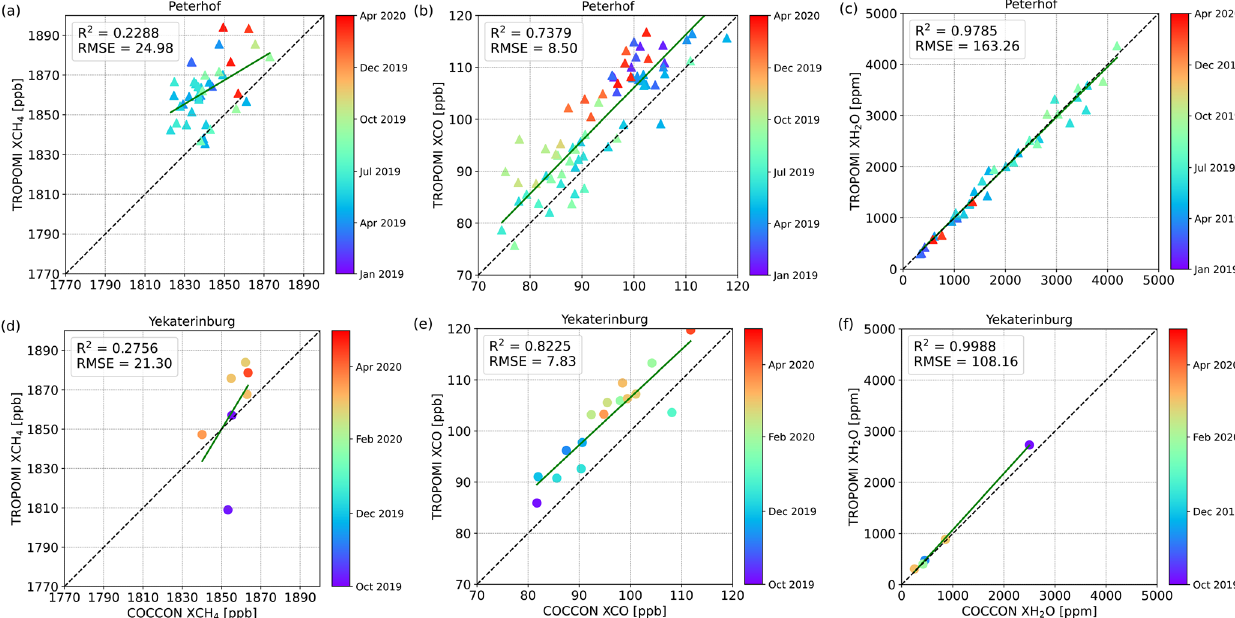
Figure 10. Correlation plots between TROPOMI and COCCON for XCH 4 , XCO and XH 2 O at Peterhof (a–c) and at Yekaterinburg (d–f) . All satellite data except XH 2 O were adjusted for the COCCON a priori profile (TCCON a priori profiles were used).